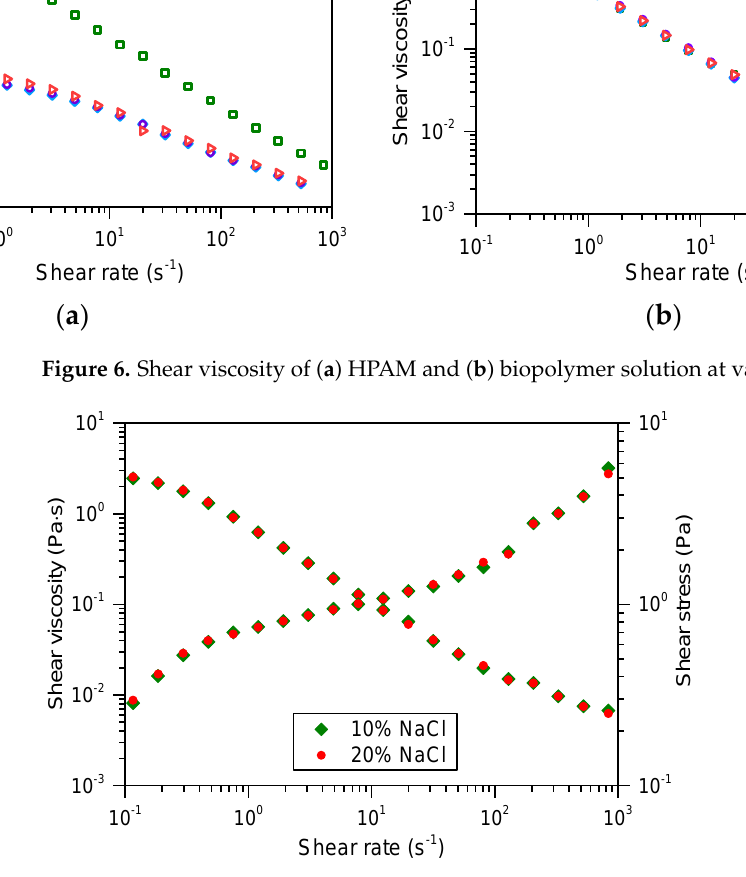
Figure 7. Rheological properties of the biopolymer at high NaCl concentrations.